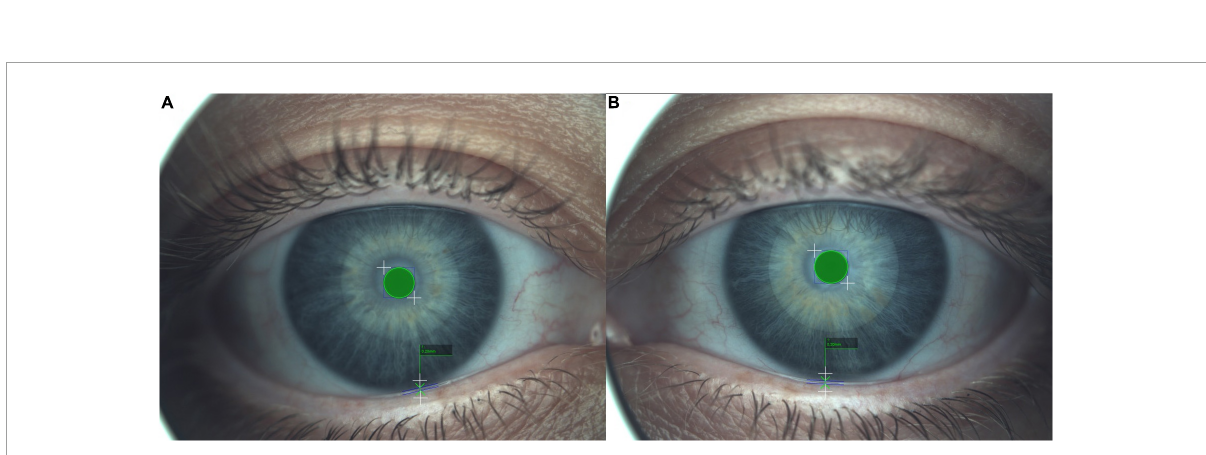
FIGURE4 Tear meniscus height (TMH) measured with the caliper. The central green circle represents a standard measure of reference to calculate the TMH. (A,B) Images represent the right and left eye, respectively. A result ≤ 0.20 mm implies an abnormal TMH and > 0.20 mm suppose a within the norm